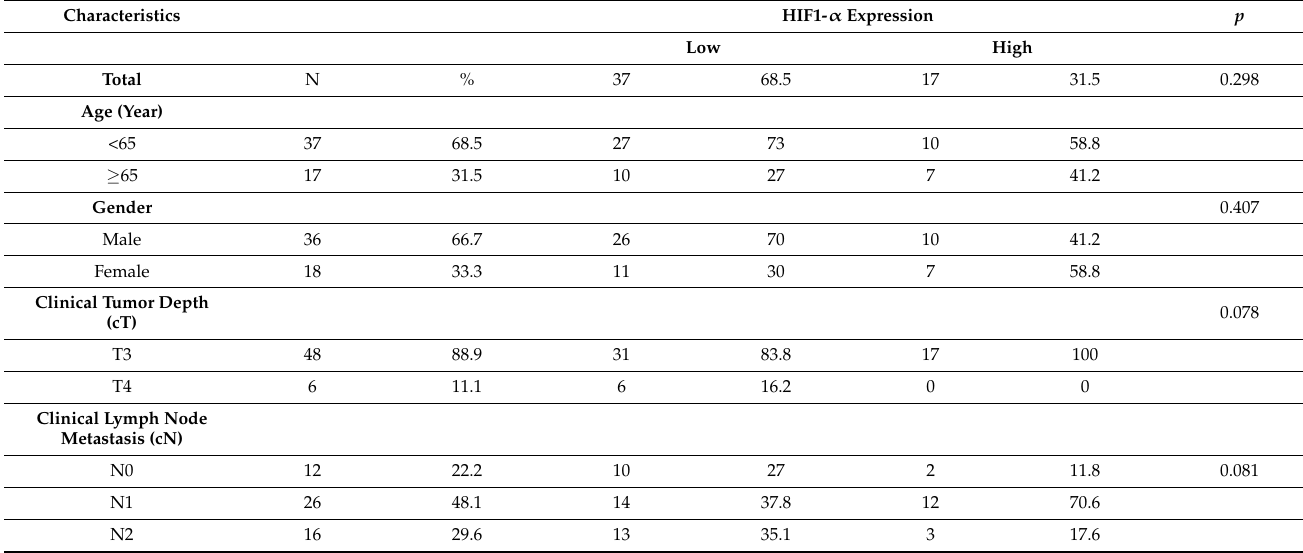
Table 2. Association between pre-CCRT HIF-1 α expression with clinicopathological parameters in 54 rectal cancer patients receiving preoperative CCRT. The Chi-square test was used for statistical analysis. The statistical significance level was *, p <